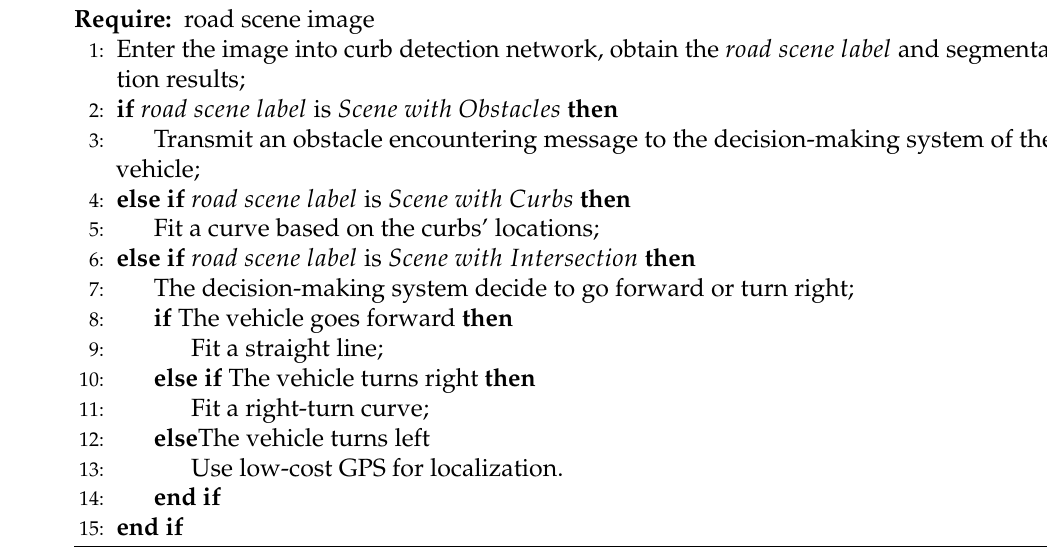
Algorithm 1 Lateral localization system